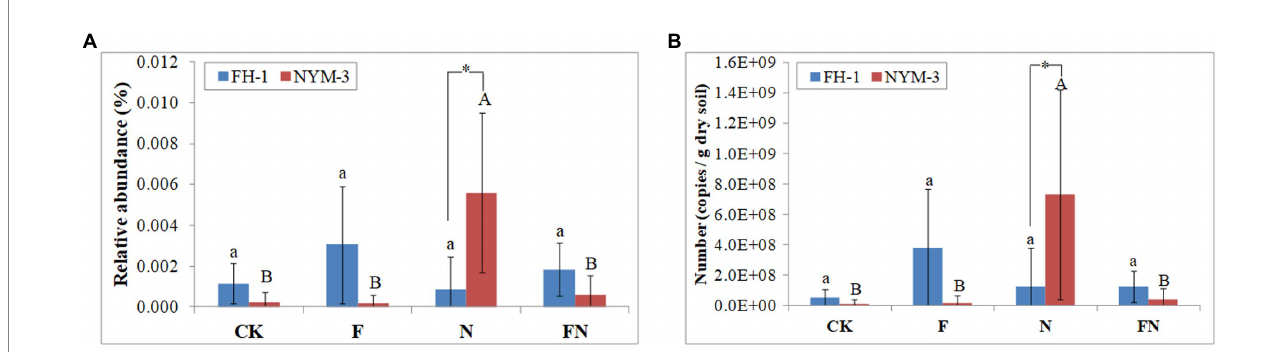
FIGURE 3 The relative abundance (A) and number (B) of B. velezensis and B. diminuta NYM-3 in rice rhizosphere soil. CK, non-inoculated; F, inoculated with B. velezensis FH-1; N, inoculated with B. diminuta NYM-3; FN, inoculated with B. velezensis FH-1 and B. diminuta NYM-3. Data followed by the different letters are significantly different at p ≤ 0.05 among different